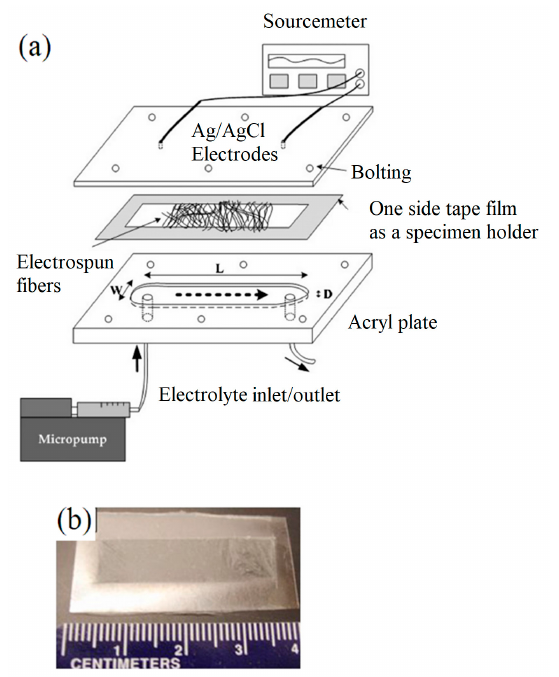
Figure 15. ( a ) Schematic of the microfluidic channel device for Zeta potential measurement of electrospun NFs ( b ) digital camera image of electrospun NF specimen. Reprinted with permission from Ref. [131]. Copyright © 2012 Elsevier Inc.